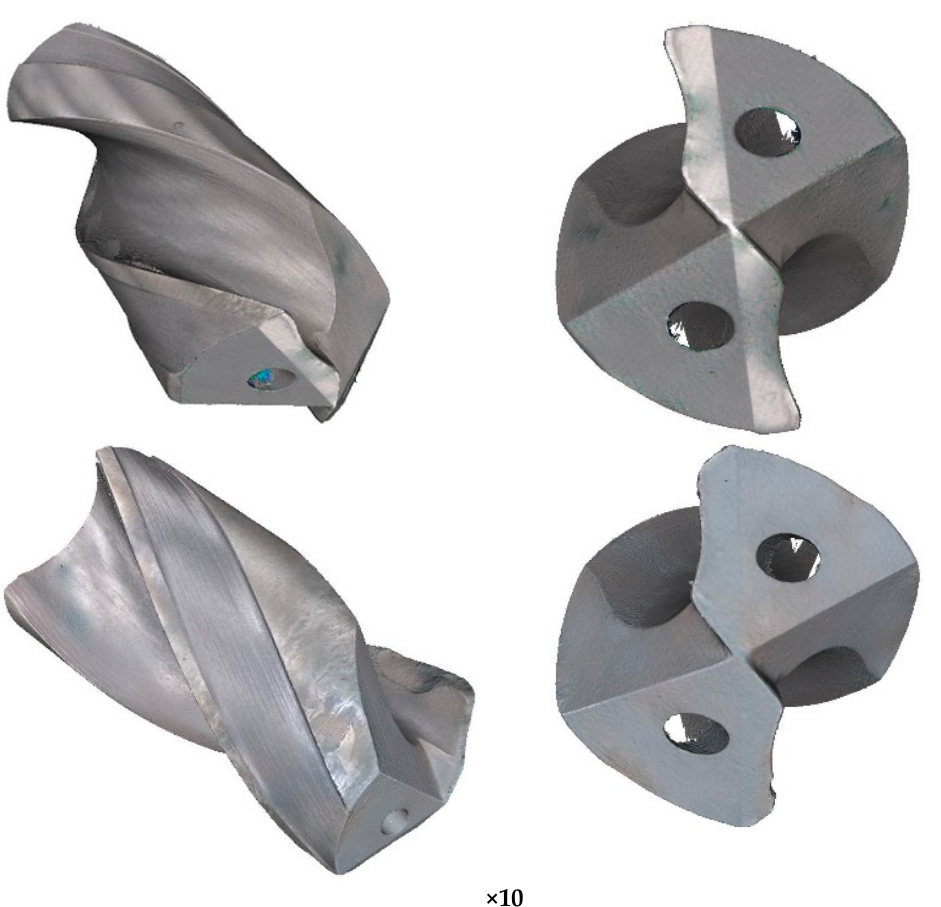
Figure 7. Perspective and frontal views of new (up) and worn (down) drill.